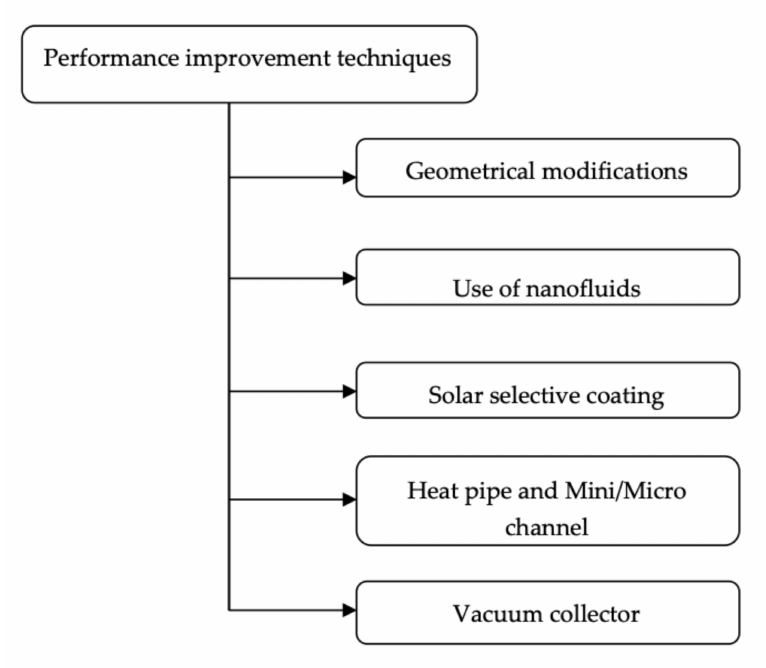
Figure 4. Performance improvement techniques of